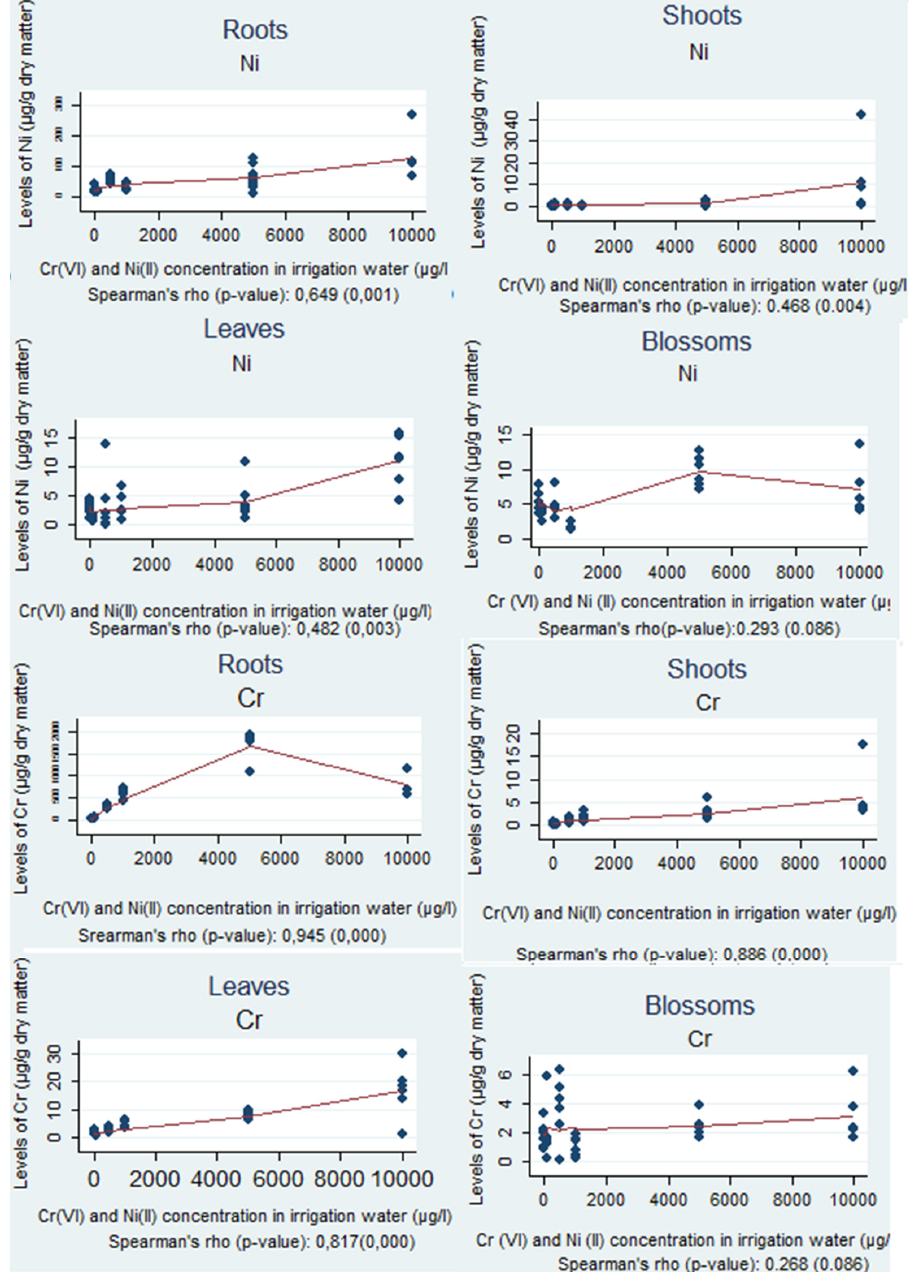
Figure 1. Correlations between the levels of chromium and nickel within each part of the plant, for every irrigation water concentration.